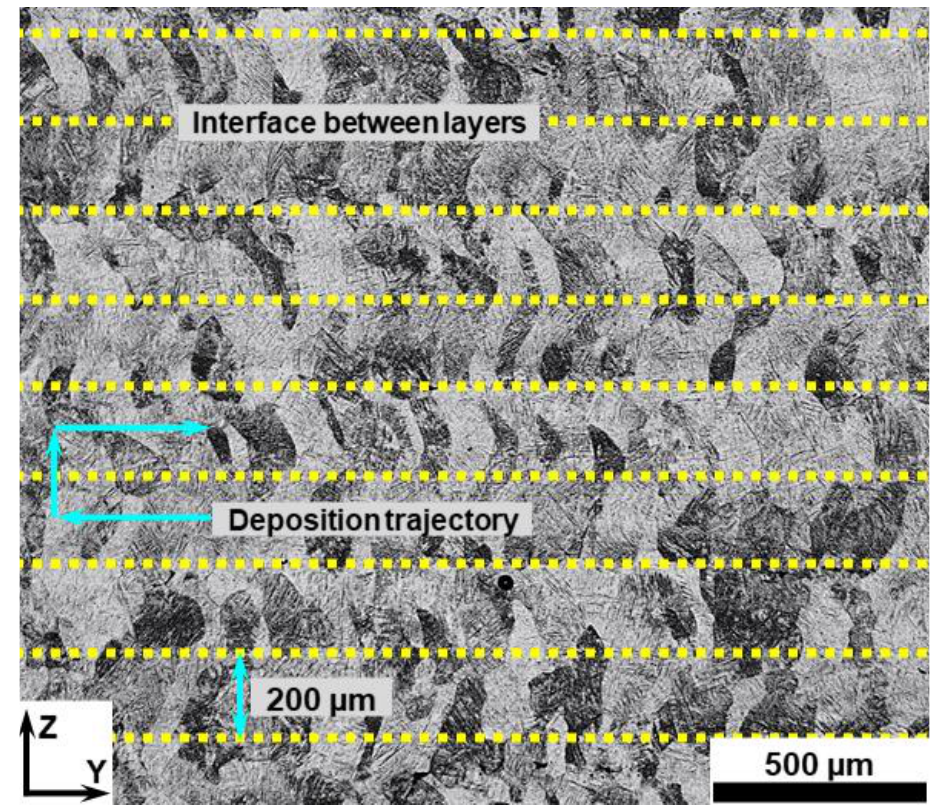
Figure 6: Longitudinal section of the WALL (f) Etching: Kroll’s Reagent.